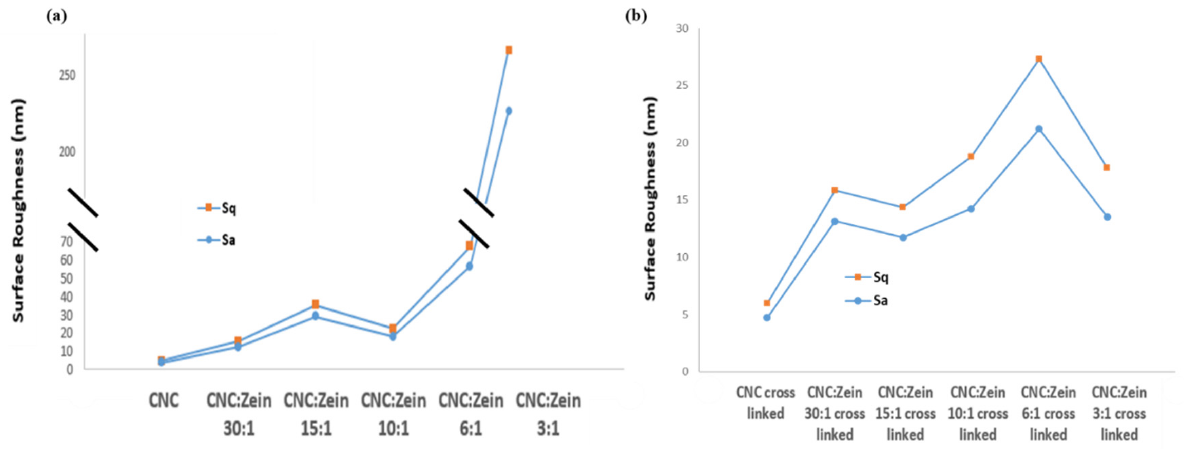
Figure 10. Effect of CZ content on surface roughness of CNC nanocomposite films. ( a ) Non-cross linked films ( b ) cross linked films.